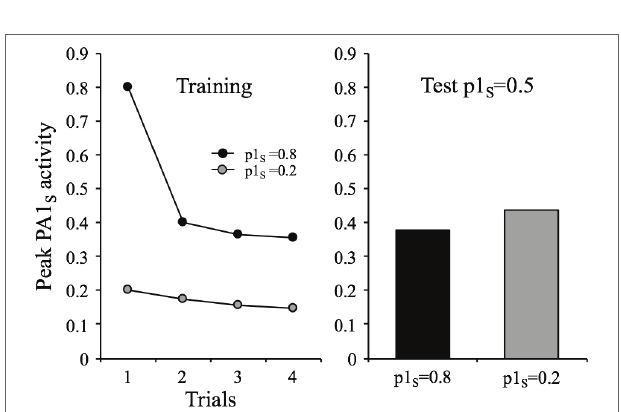
FIGURE 6 | Simulated peak PA1 S activity over 4 presentations of a 1-moment duration stimulus at a 32-moments ISI, under two intensity conditions: high intensity ( p 1 s = 0.8) and a low intensity ( p 1 s = 0.2). The bar graph depicts the peak PA1 S activity in a single spontaneous recovery test- trial for the two training conditions tested with a common p 1 s = 0.5.